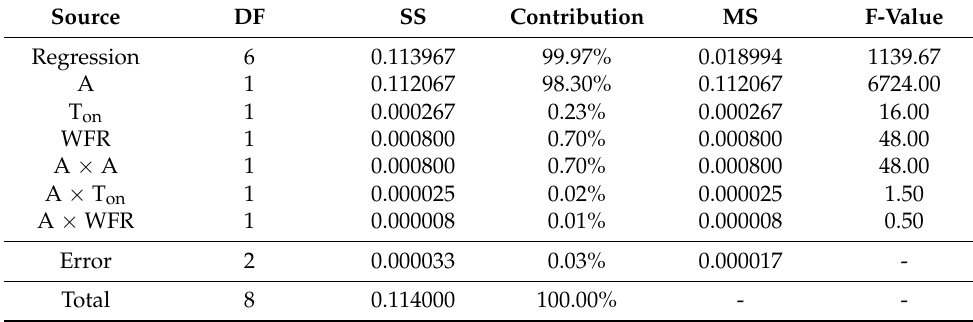
Table 3. Analysis of variance: kerf width—Al6351–5% SiC–3% B 4 C.